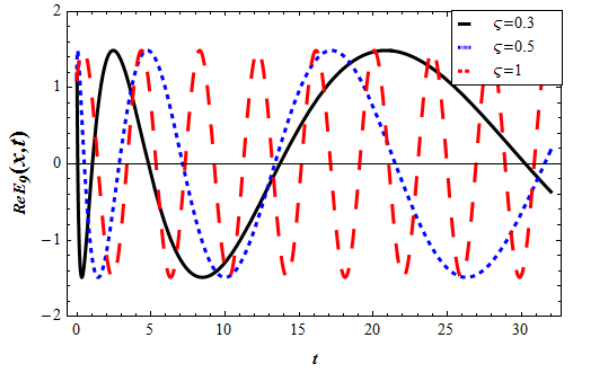
Figure 5. Variation of solution (21) versus t and ς